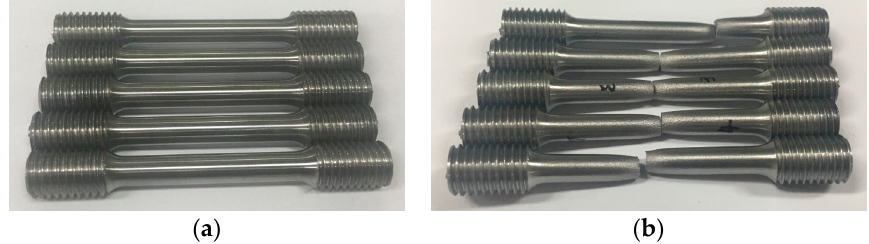
Figure 4. Tensile specimens: ( a ) before tensile test and ( b ) after tensile test.